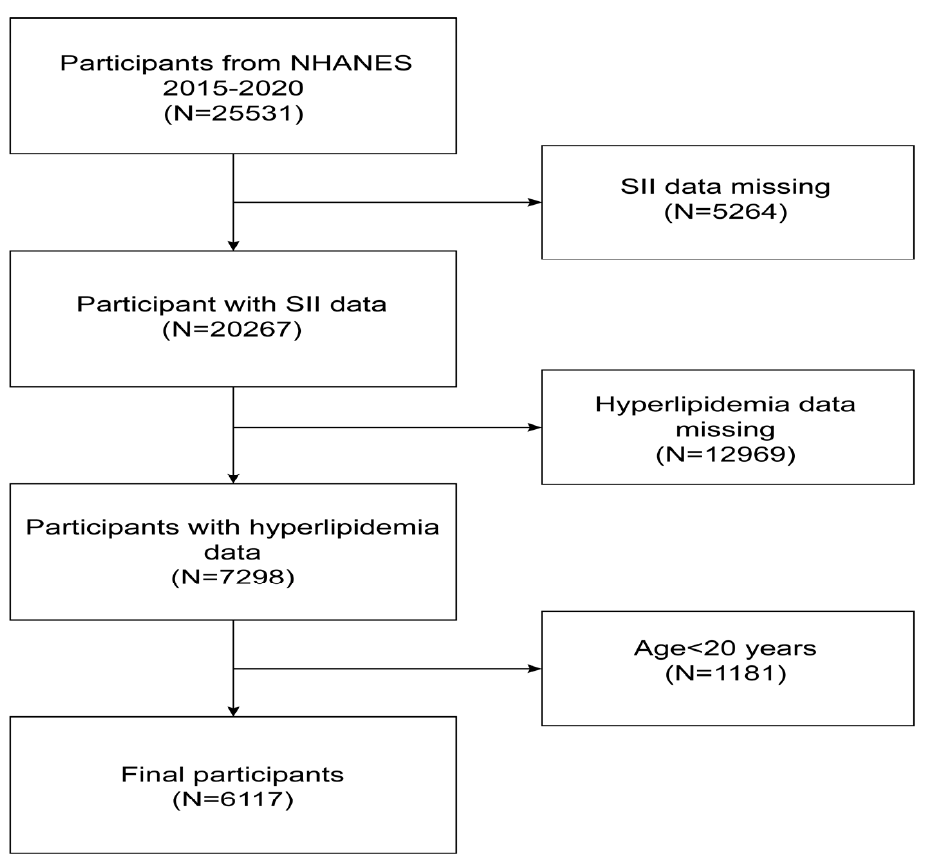
Figure 1. Flowchart of participant selection. NHANES, National Health and Nutrition Examination Survey.